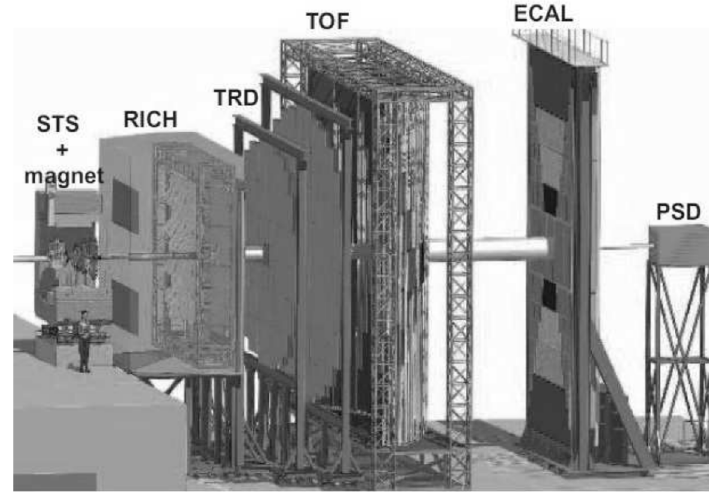
Figure 1. The electron-hadron configuration of the CBM experimental